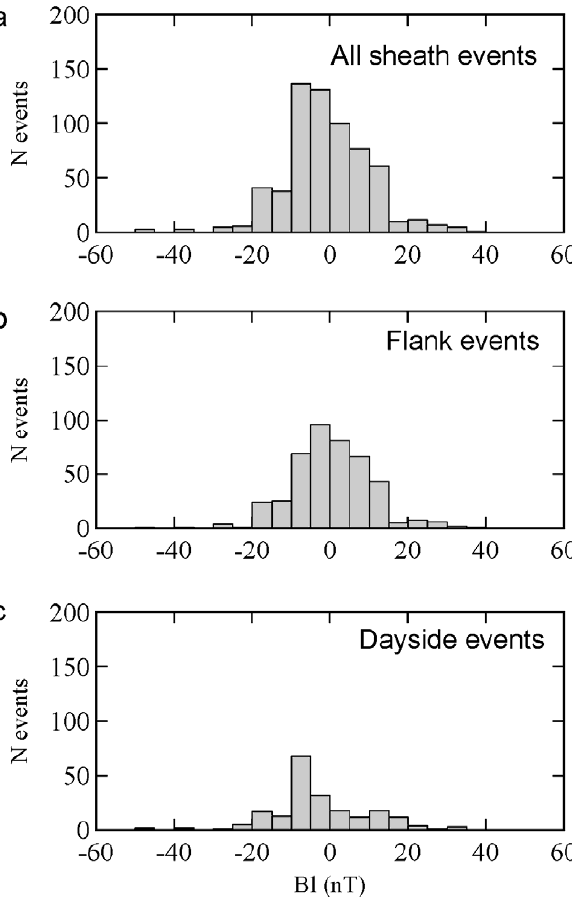
Fig. 8. Histograms of event occurrence as a function of Bl for (a) all magnetosheath events, (b) magnetosheath FTEs with | Y GSM | > 10 R E , and (c) magnetosheath FTEs with | Y GSM | < 10 R E . assigned to the IMF B z = 0 category. When presented in his- tograms, they were divided equally and added to the two bins bounding 0 nT. Of 203 dayside | Y GSM | < 10 R E mag- netosheath events, 128 (63 %) occurred for magnetosheath Bl < 0 nT, but only 50 (25 %) for Bl > 0 nT, and 25 events were observed for Bl = 0. By contrast, of 435 flank ( | Y GSM | > 10 R E ) magnetosheath events, 209 (48 %) occurred for mag- netosheath Bl < 0 nT, and 198 (45 %) for Bl > 0 nT, and 28 events were observed for Bl = 0. Sibeck et al. (2005)